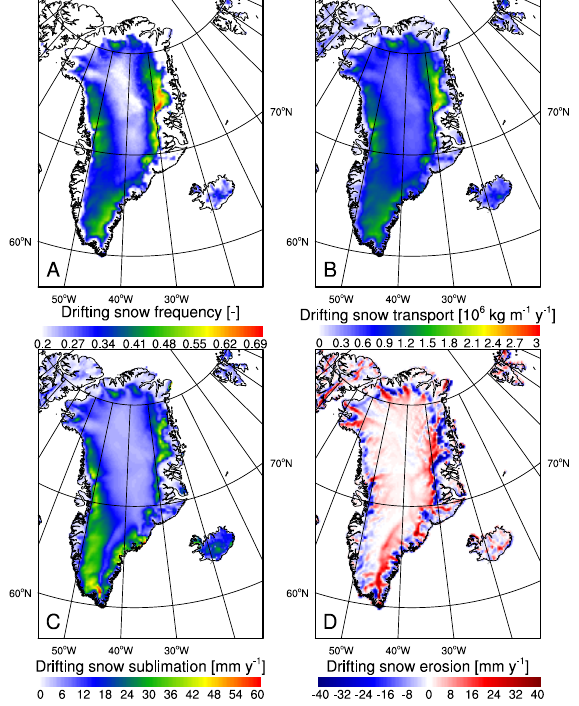
Fig. 5. Mean drifting snow frequency (A) , transport (B) , sublima- tion (C) and erosion (D) . Drifting snow frequency is defined as the fraction of days with accumulated TR ds of 3kg m − 1 . Dashed- dotted lines represent the topography with 500m intervals.